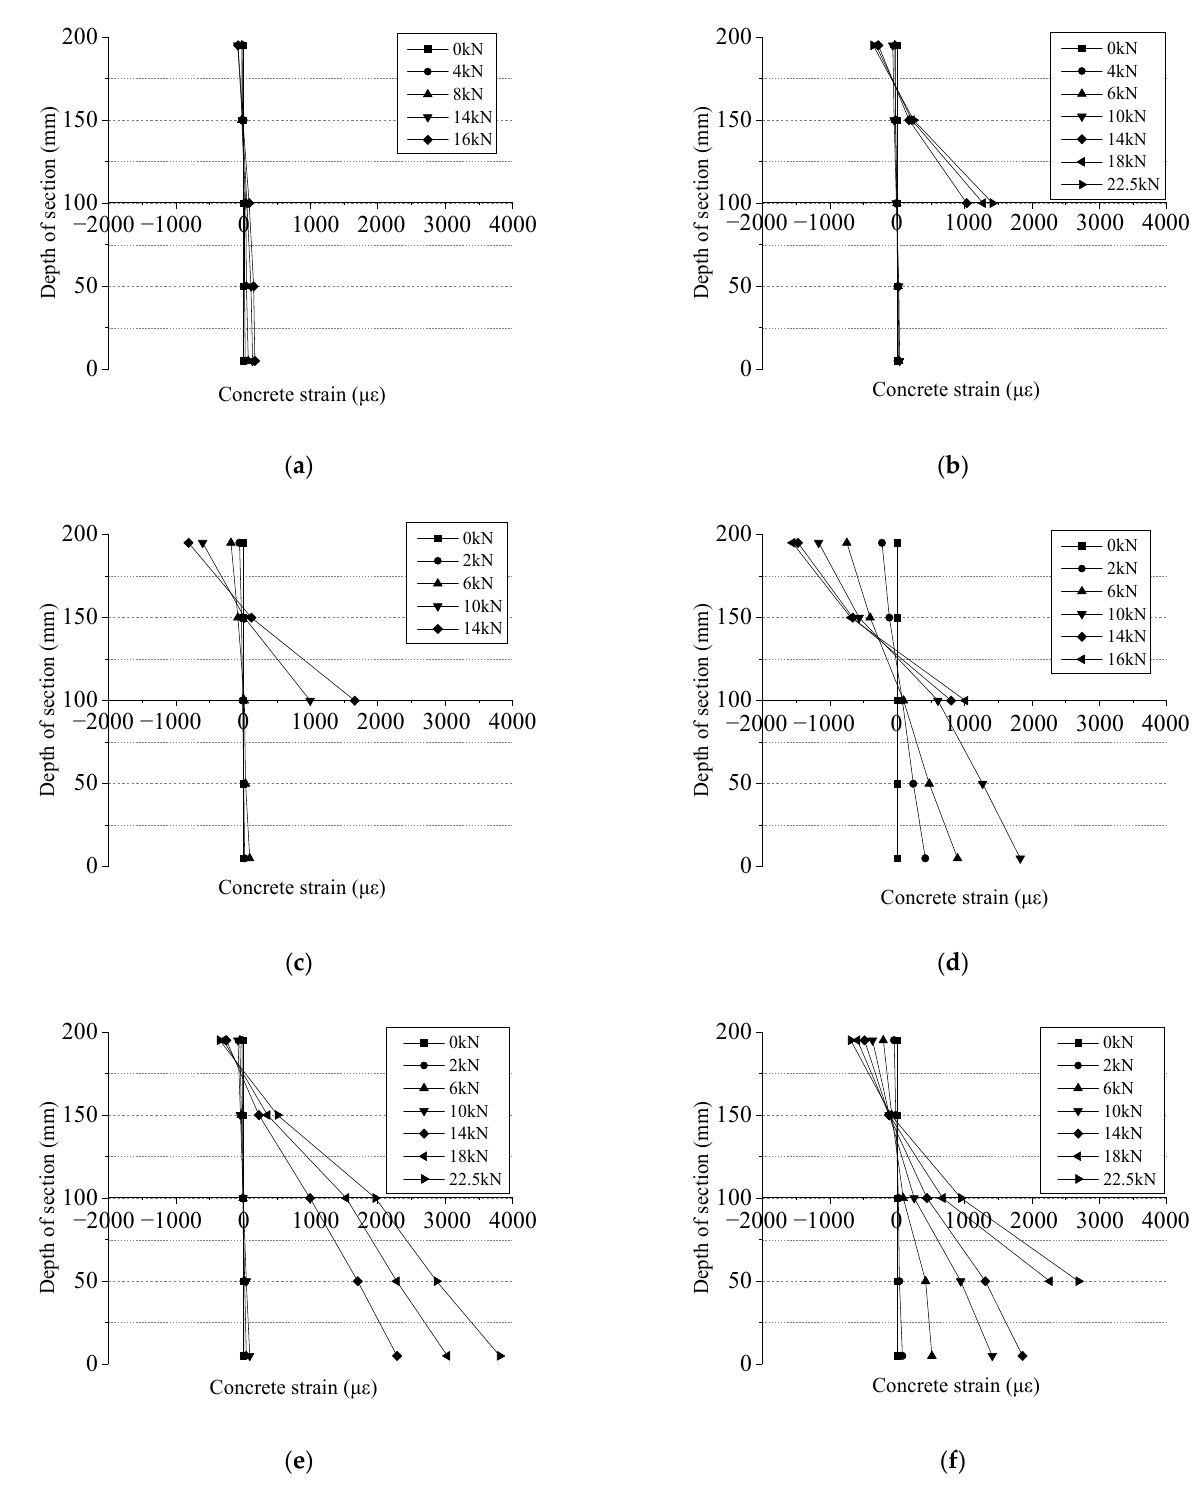
Figure 7. The concrete strain distribution along the section depth at the mid-span section of the tested beams: ( a ) G-25; ( b ) G-200; ( c ) G-400; ( d ) G-600; ( e ) C-25; ( f ) C-400.